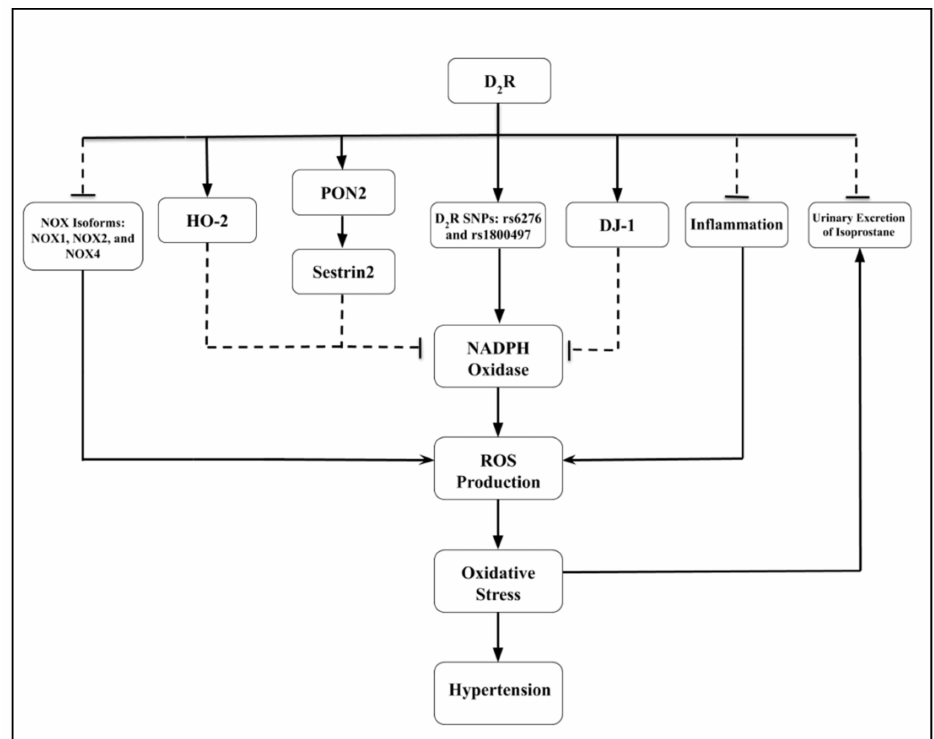
Figure 3. Schematic diagram displaying the role of renal D 2 R and interrelated components on the development of hypertension. The dashed lines illustrate inhibitory effects and solid lines illustrate stimulatory effects. D 2 R, Dopamine D 2 Receptor; D 2 R SNPs, Dopamine D 2 Receptor Single Nu- cleotide Polymorphisms; DJ-1, Park 7; HO-2, Heme-Oxygenase-2; NOX, NADPH oxidase; PON2, Paraoxonase